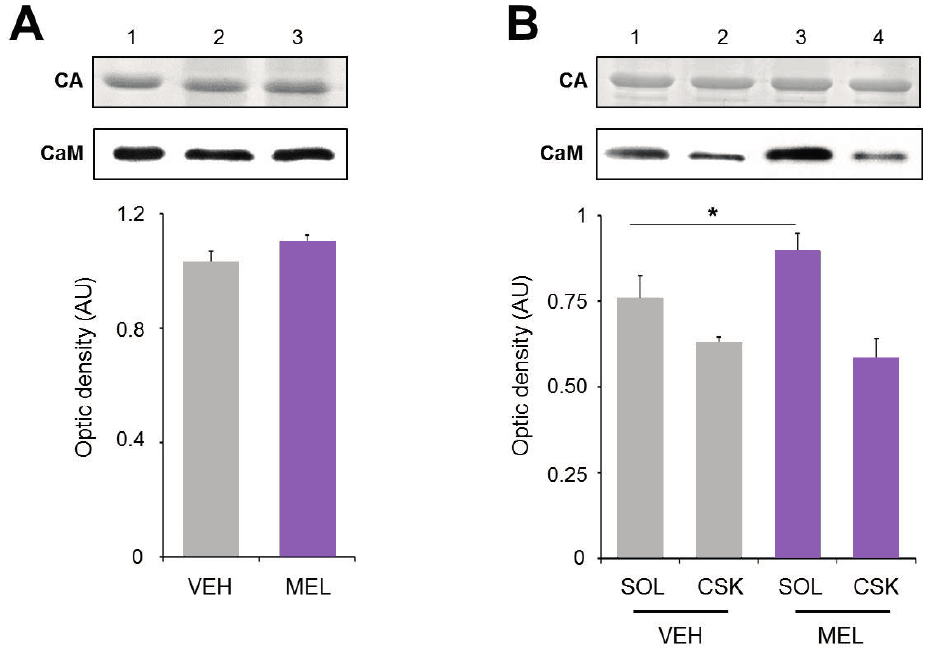
Figure 5. Calmodulin content in hippocampal slices treated with Melatonin. Hippocampal slices were incubated during 6 h with either the vehicle (VEH) or melatonin (MEL). Calmodulin (CaM) in the homogenates ( A ); and in the soluble (SOL) and cytoskeletal fractions (CSK) separated by centrifugation ( B ); was determined by Western blot. Upper panels show Carbonic Anhydrase (CA) used as external load control and stained with Coomassie blue. Representative fluorograms of CaM are shown immediately